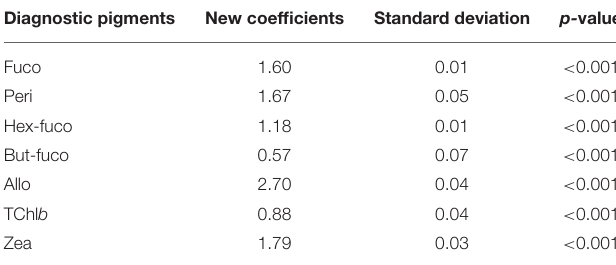
TABLE 2 | Best estimates (new coefficients) of the “TChl a to DP” ratios for the Mediterranean SeaBASS subset with their standard deviation and significance value ( p